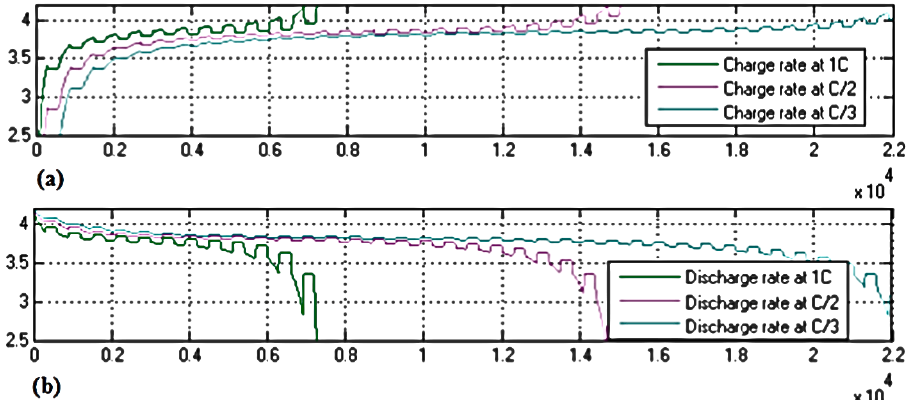
Figure 2. Voltage profile of the lithium-ion battery model at different ( a ) charge rates and ( b ) discharge rates.